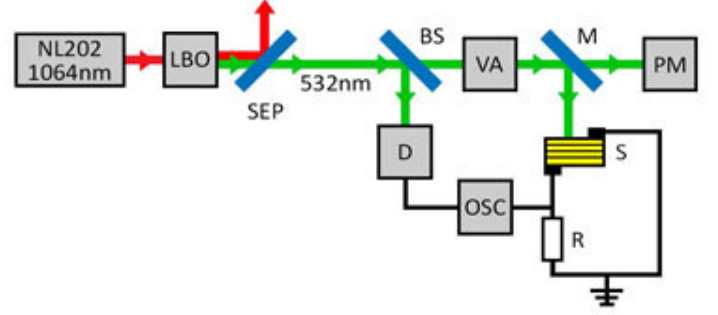
Figure 2. The scheme of the experimental setup of transient photovoltage measurement. NL202 is the diode-pumped Nd:YAG laser; LBO is the nonlinear crystal for the second harmonic generation; SEP is the Nd:YAG laser harmonic separator; BS is the beam splitter plate; VA is the variable attenuator for 532 nm laser beam; M is the removable high-reflectance mirror; S is the sample solar cell; R is the load resistor; PM is the optical power meter; D is the optical signal reference detector; OSC is the digital storage oscilloscope.